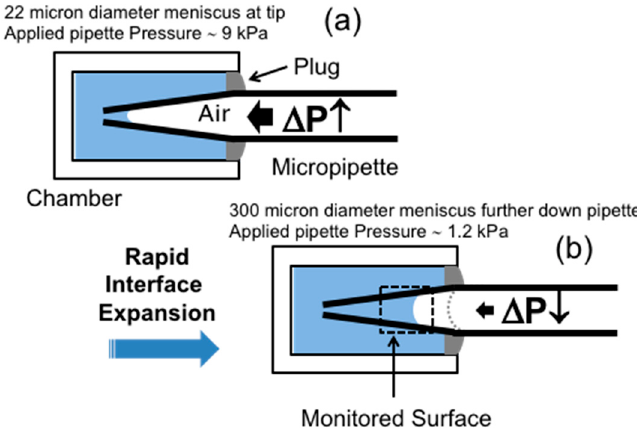
Figure 10. Schematic image of the Dynamic Surface Tension (DST) measurement using the Micropipette Interfacial Area-expansion Method. ( a ) The micropipette is inserted into the surfactant solution under high positive applied pipette pressure such that the new interface meniscus (diameter ~22 µ m) is close to the pipette tip. This is observed by initially positioning the micropipette tip in the field of view. To avoid convective flow inside the chamber, the microchamber is gently sealed with a plug of hexadecane after the pipette is inserted and the pipette moved to a new viewing position where a clean surface is expected to locate when a pre-set lower pipette pressure is applied. ( b ) Following a 15-fold decrease of the applied pipette pressure, ∆ P , (from the high value of ~9 kPa, that held the interface close to the pipette tip, to 0.6 kPa), the surface area quickly expands to a new diameter of ~300 µ m in 0.1 to 0.3 s. The pipette pressure is rapidly fixed to a constant reset pressure of 1.2 kPa, and the surface meniscus moves to the observed region (dotted box). The movement of the surface meniscus is tracked as surfactant adsorbs to the water-air surface and reduces the tension to the new equilibrium. With permission from Elsevier [7].